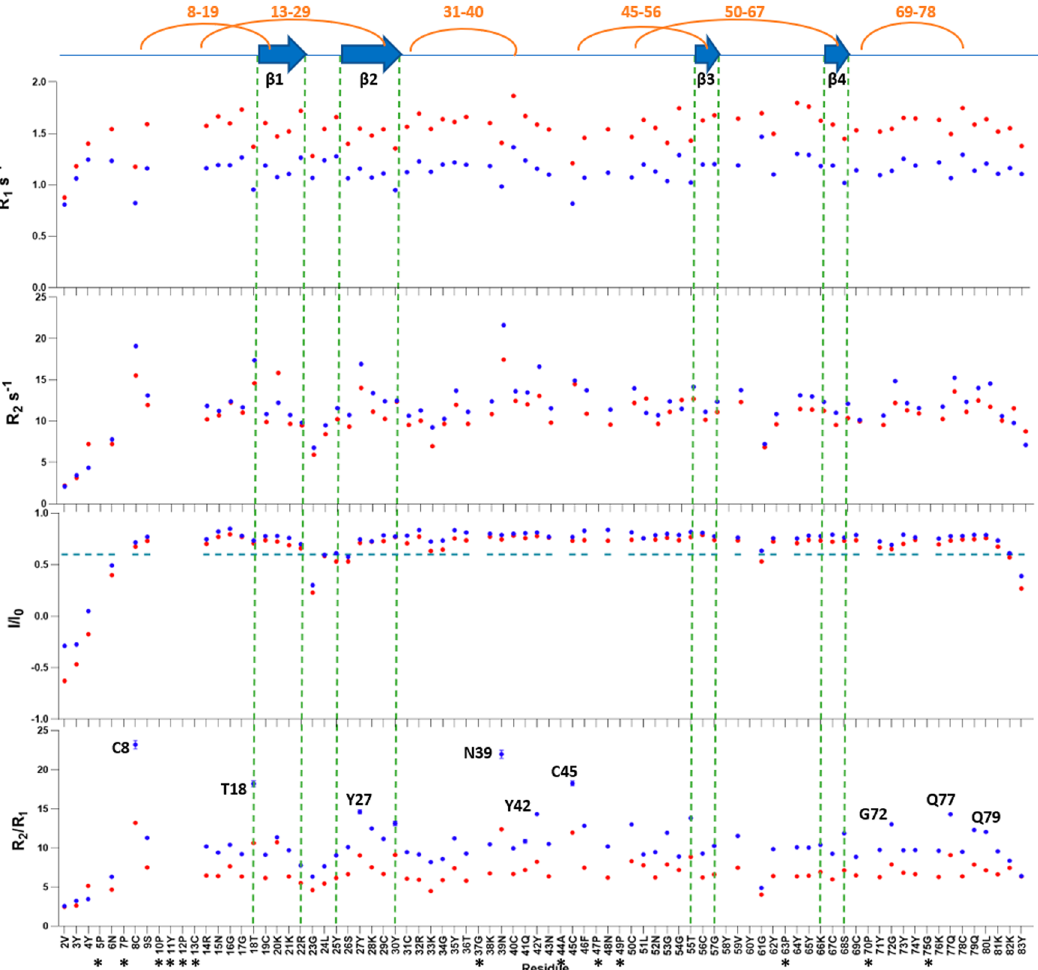
Fig. 1 Dynamic features of Pvfp-5 β . 15 N-R 1 , 15 N-R 2 , hetNOE, and R 2 / R 1 ratio at 298 K measured for all Pvfp-5 β residues at both 14.1 T (blue dots) and 18.8 T (red dots). β -strands are indicated as blue arrows at the top of the fi gure, while yellow curves indicate disul fi de bonds. Black asterisks indicate proline residues or residues with peaks in overlap in the NMR experiments. In bold residues showing no-fast local motions within the ms- μ s